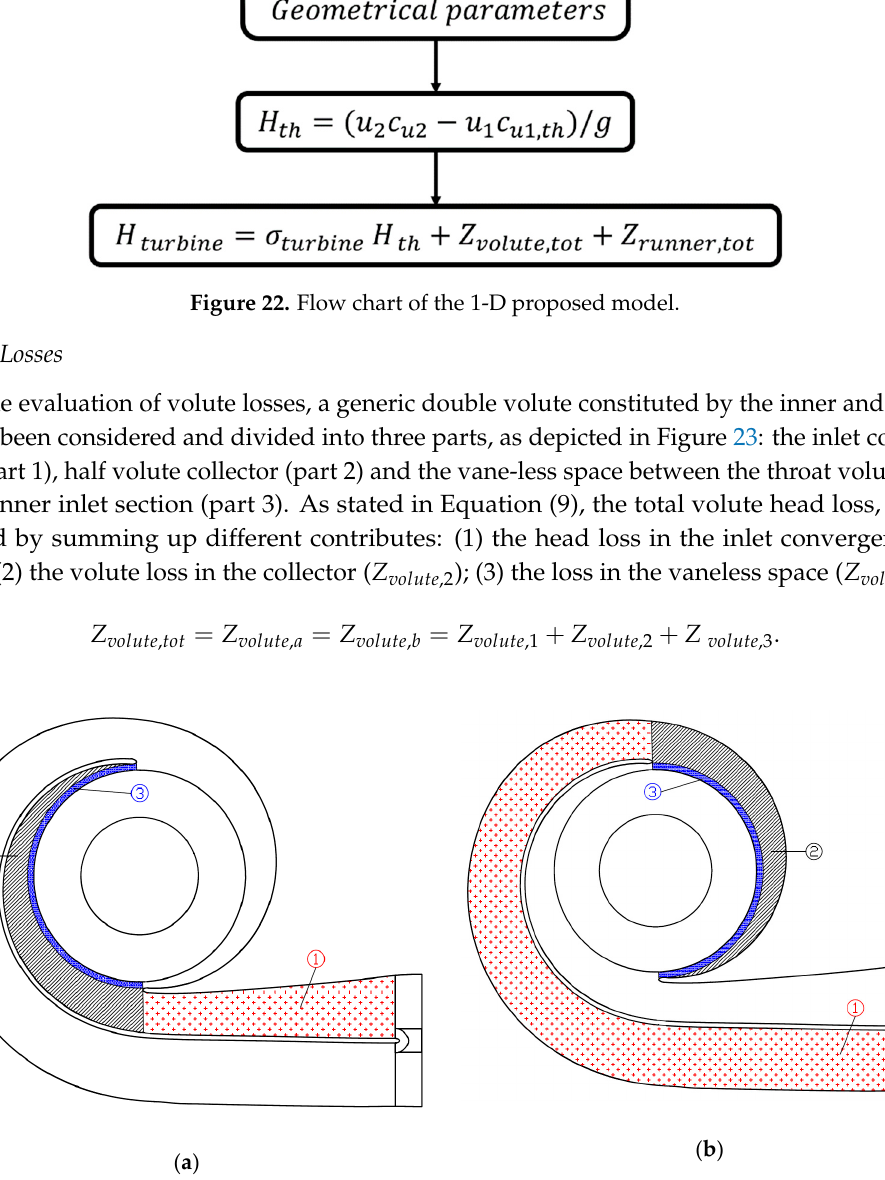
Figure 23. Division of the double volute: inner volute ( a ) and outer volute ( b ).